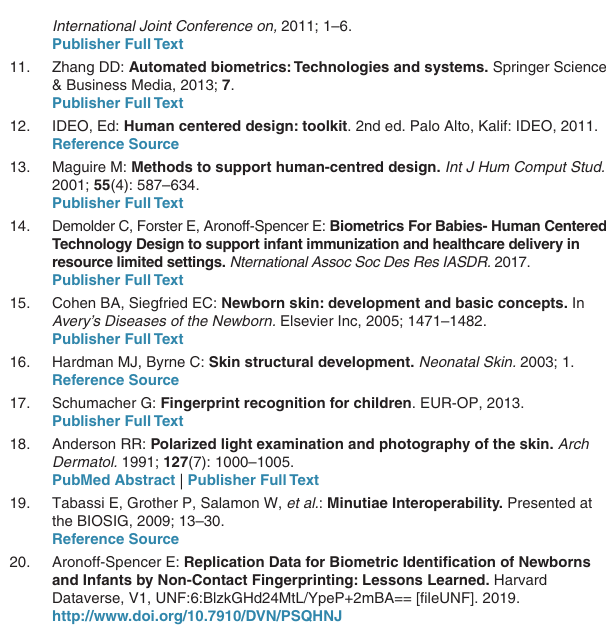
Reference Source 20. Aronoff-Spencer E: Replication Data for Biometric Identification of Newborns and Infants by Non-Contact Fingerprinting: Lessons Learned.